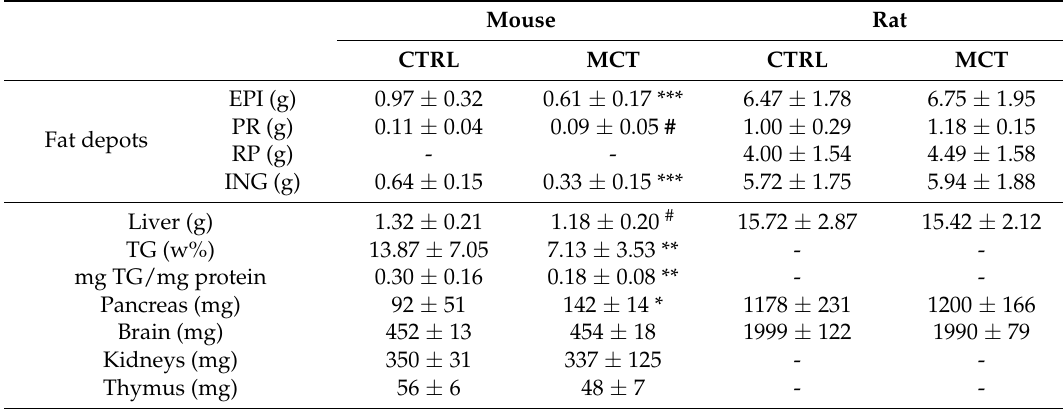
Table 3. Average weight of fat depots and organs at PN 98 1 .